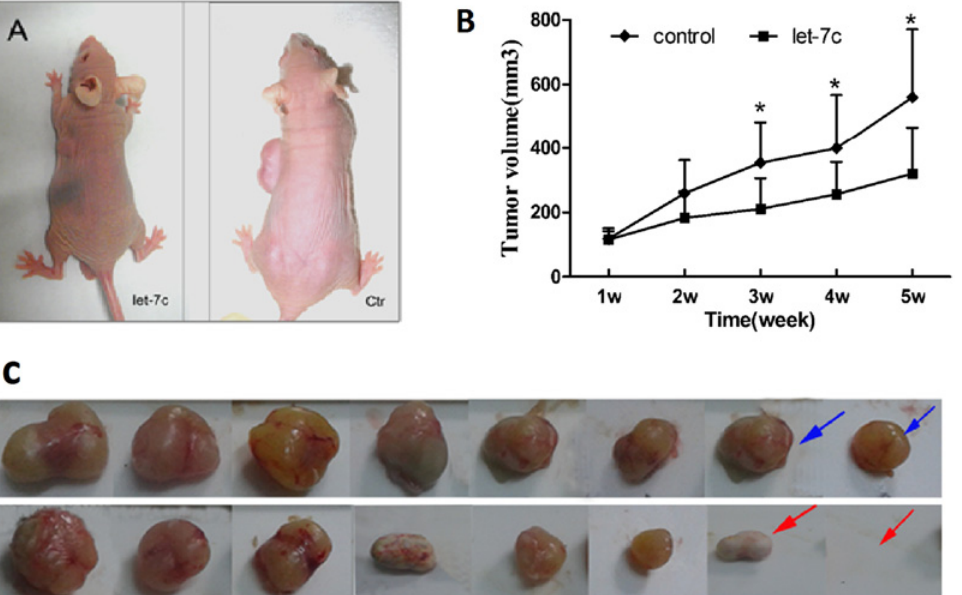
Fig 3. Let-7c agomir inhibits tumor growth in a xenograft mouse model of HCC in vivo. (A) Photographs of tumor-bearing mice in the fifth week after injection with let-7c agomir (Left) or negative control (Right). (B) From seventh day after the injection, measurements of tumor size were taken every 7 days for 5 weeks. Effects of let-7c agomir on the xenograft mouse model are shown. Data are shown as the mean ± S.D. The statistical difference was analyzed by the two-sample t test. (C) Photographs of tumors that developed in the mouse model of HCC treated with let-7c or the negative control are presented. The two smallest tumors with the let-7c treatment are indicated by red arrows, and the two smallest tumors in the negative control group are indicated by blue arrows.